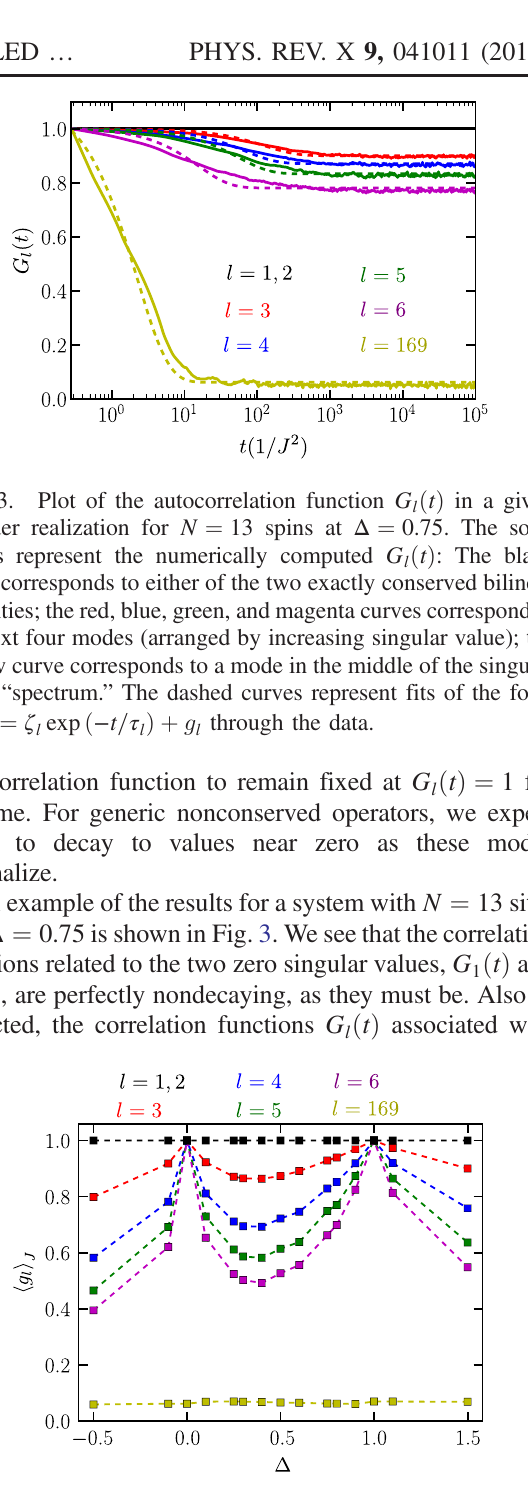
G t → ∞ Þi FIG. 4. Plot of the plateau values h g as a l i J ¼ h l ð J function of the anisotropy Δ for N ¼ 11 spins ( S ¼ 1 = 2 ). The brackets h … i denote an average over 2000 disorder realizations J for the f J . Different colors correspond to different modes: i g Black corresponds to the two lowest and exactly conserved modes; red, blue, green, and magenta correspond to the next four modes; yellow corresponds to a mode in the middle of the singular-value spectrum. We find no strong dependence on the system size N : See Fig. 5 for a plot of the plateau value h g as a l i J function of the system size N for the l ¼ 3 (red) mode at Δ ¼ 0 . 5